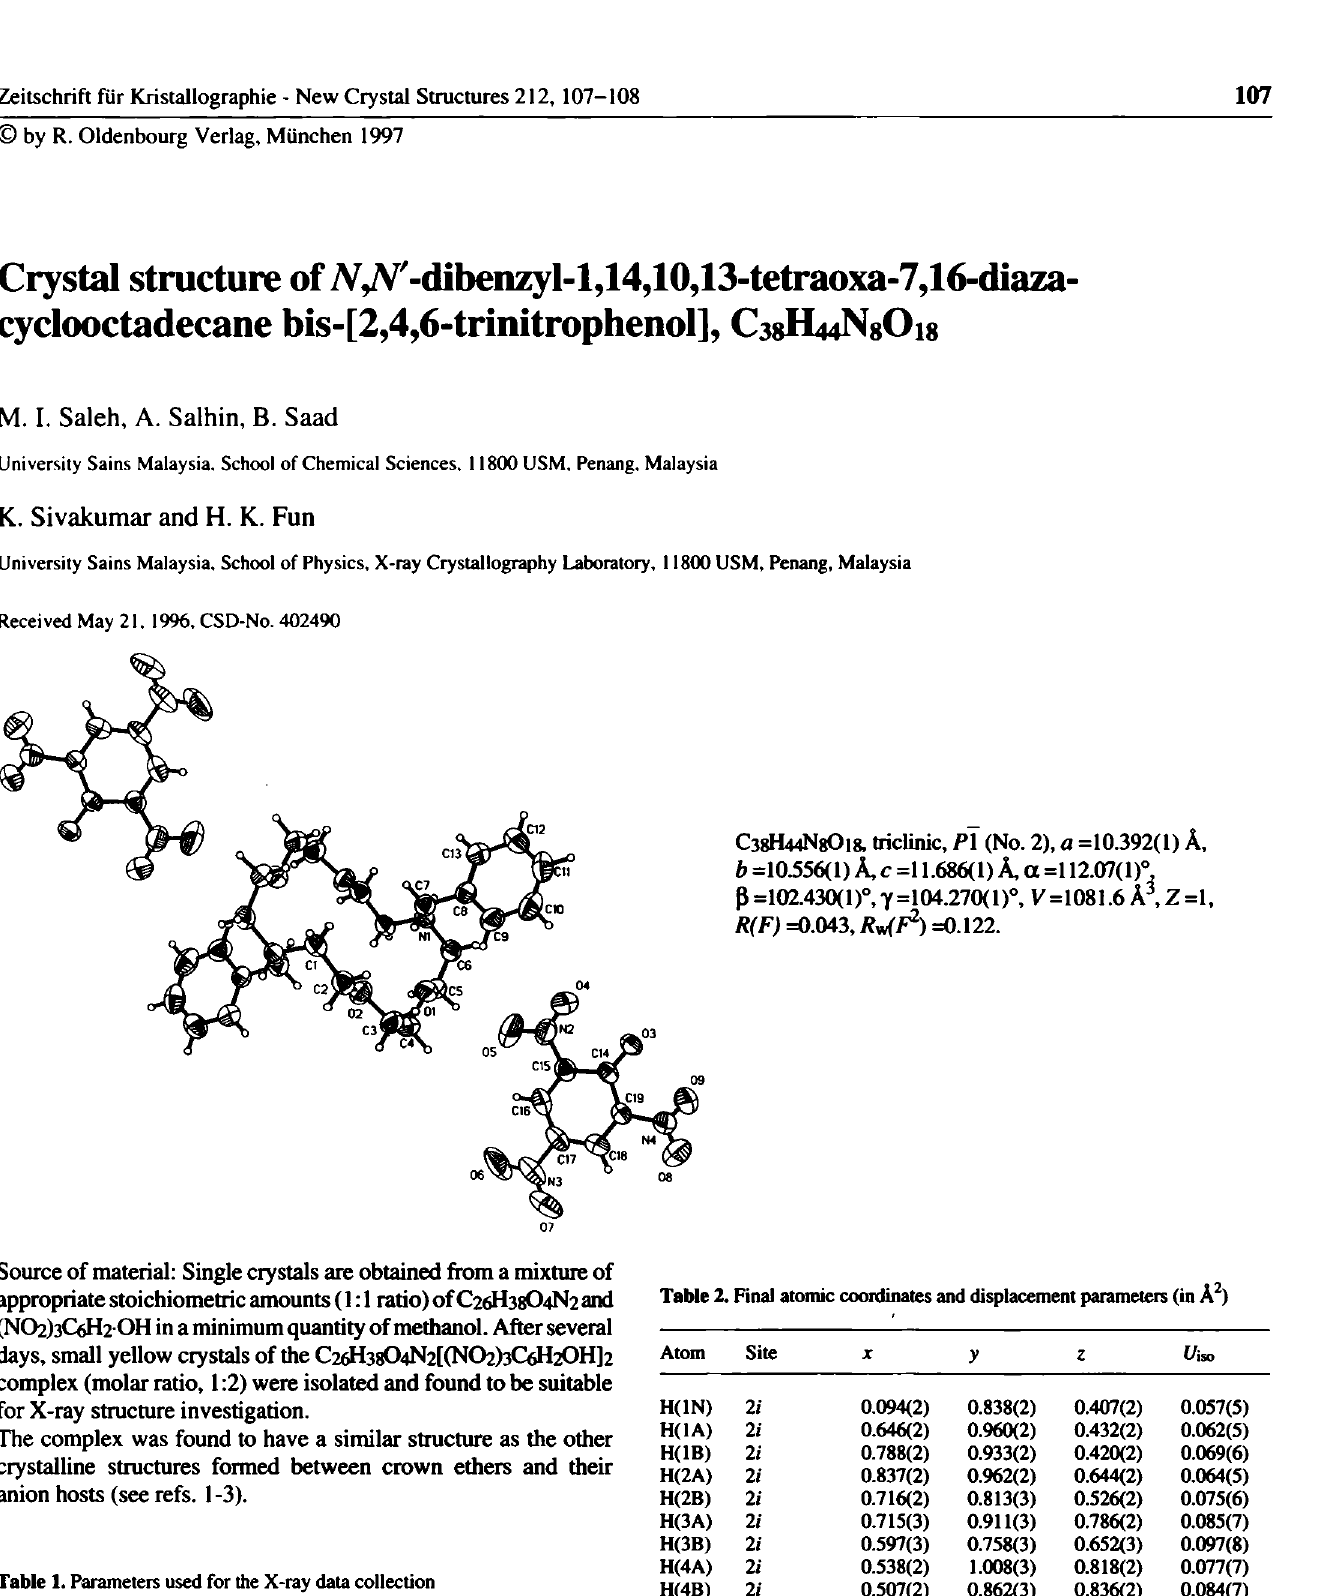
Table 1. Parameters used for the X-ray data collection